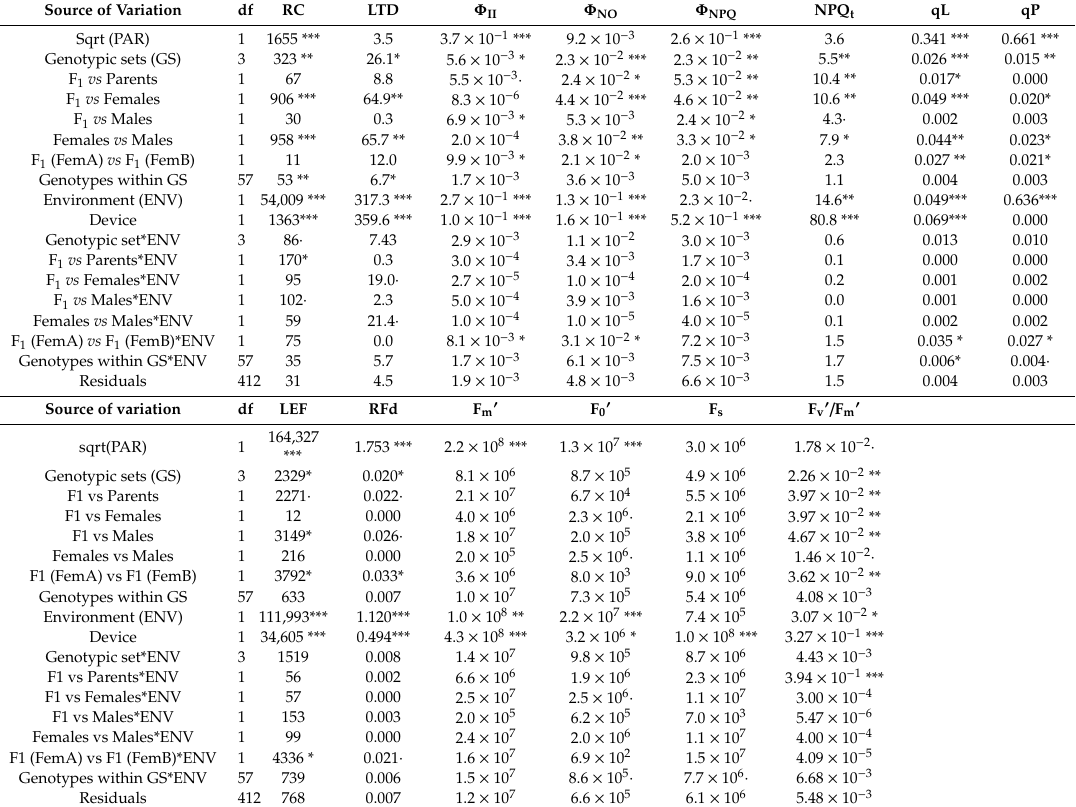
Table 2. E ff ects of genotypic set , environment , device, genotypic set by environment interaction, and contrasts on variables assessed using MultispeQ. The values under each variable’s heading correspond to mean